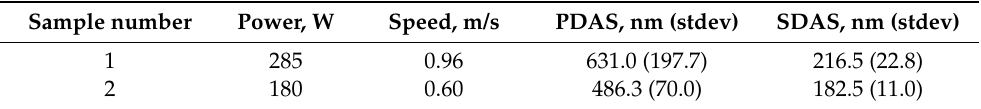
Figure 1. Equilibrium Fe and Nb concentration in the liquid and solid phases in the model Ni–Fe–Nb alloy as a function of temperature. X m and X p are the concentrations of Fe in liquid and solid respectively, and Y m and Y p are the corresponding values for Nb.